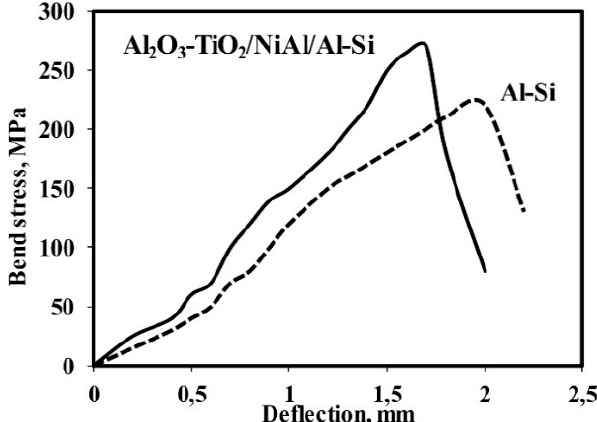
Figure 9. Bend test curves recorded for: the Al 2 O 3 -15 wt.%TiO 2 /NiAl/Al-Si coating system and Al-Si cast alloy.